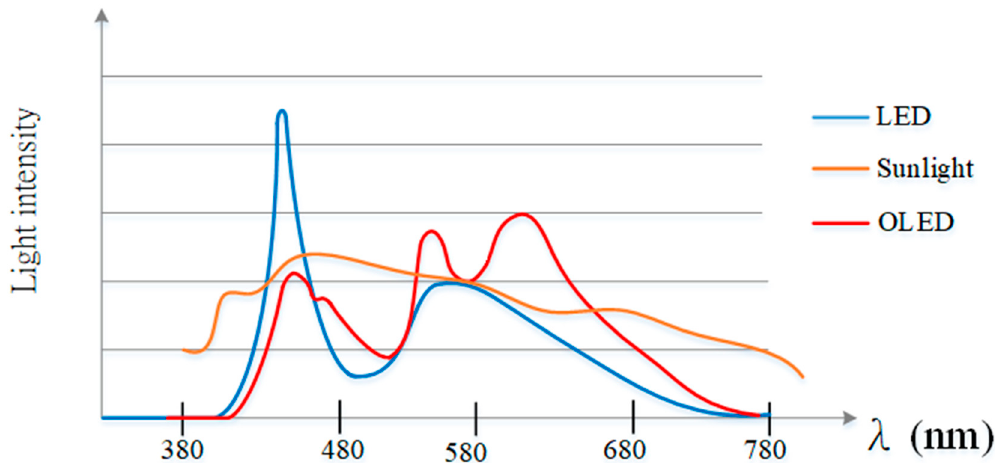
Figure 1. Light-emitting diode (LED), organic light-emitting diodes (OLED), and sunlight of waveform.